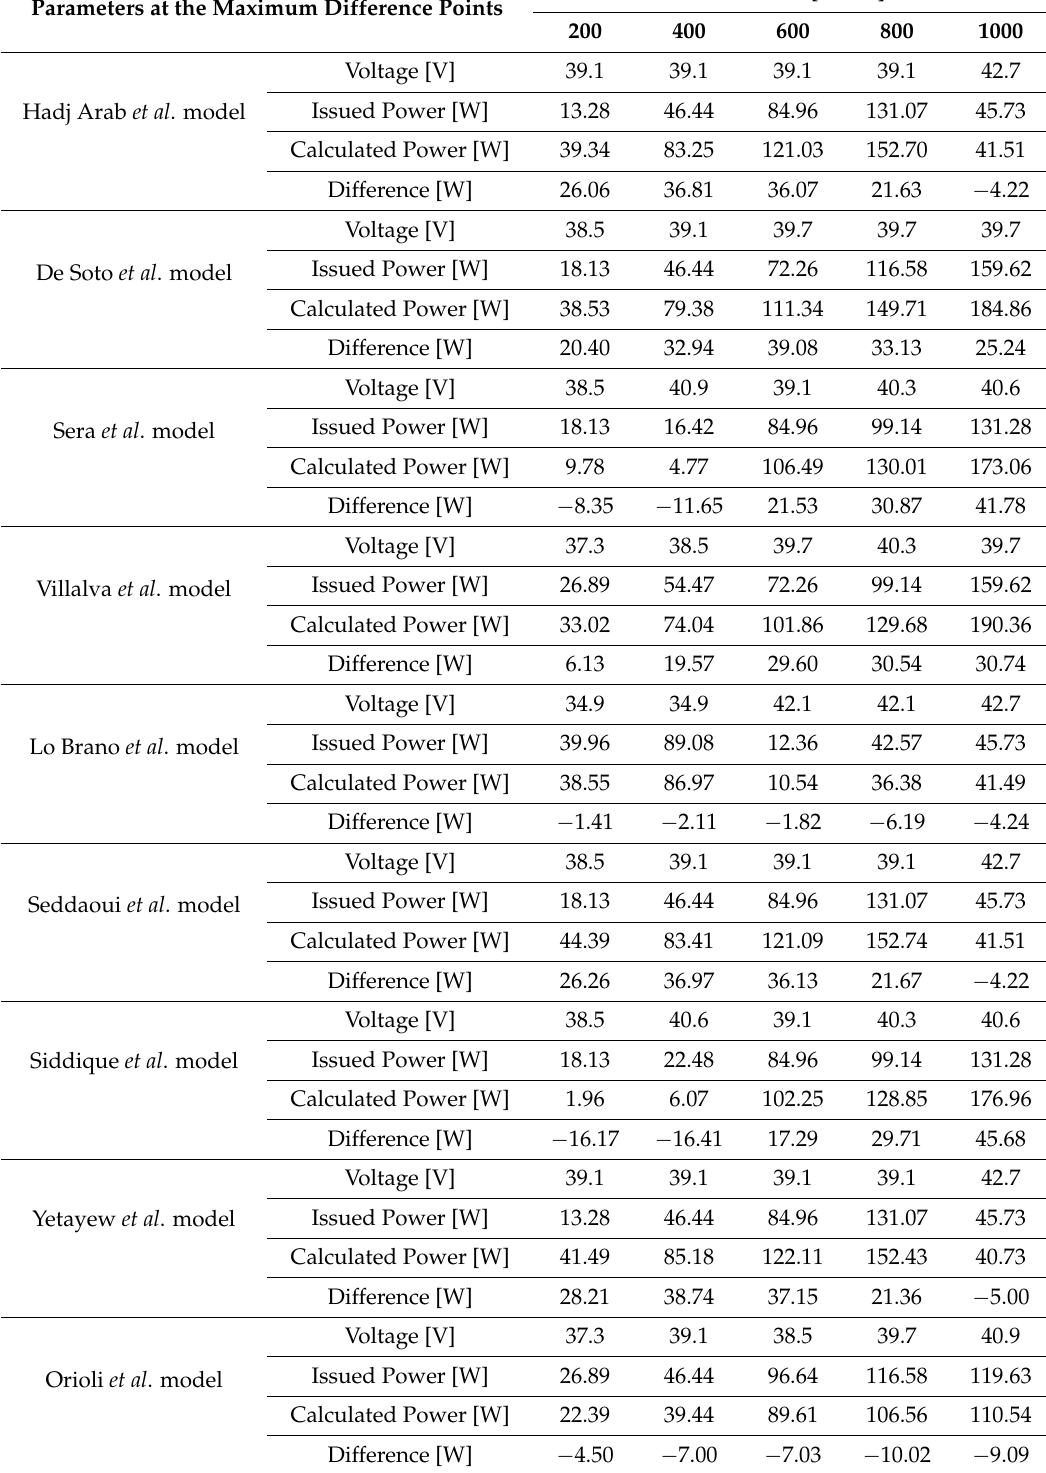
Table 12. Maximum power differences between the calculated and the issued I-V characteristics of Sanyo HIT-240 HDE4, at temperature T = 25 ˝